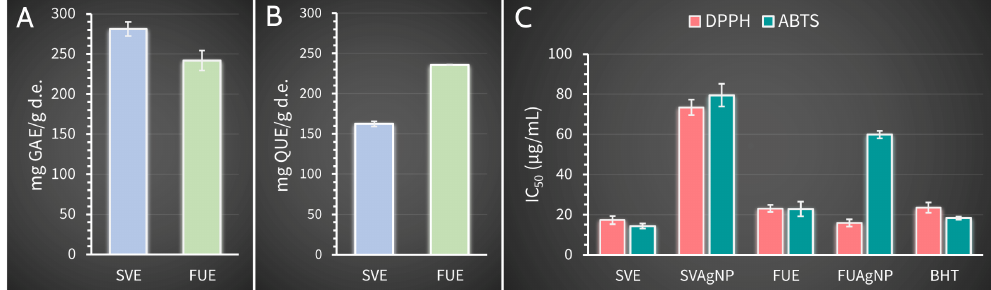
Figure 7. Total phenolic ( A ) and flavonoid ( B ) content of S. verticillata and F. ulmaria aqueous extracts and the antioxidant activity ( C ) of synthesized SVAgNP and FUAgNP and corresponding extracts.